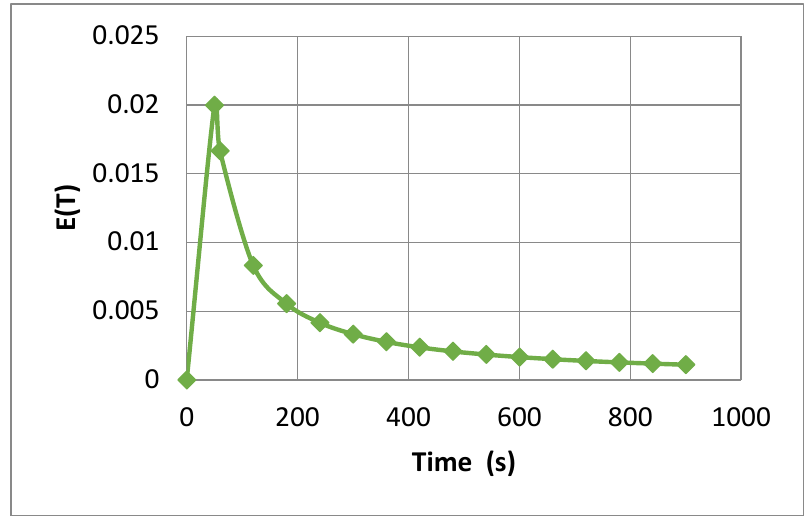
Figure 2. Residence time distribution (RTD) curve in nanofiltration process. Table 3. Results of residence time distribution of Nanofiltration reactor.